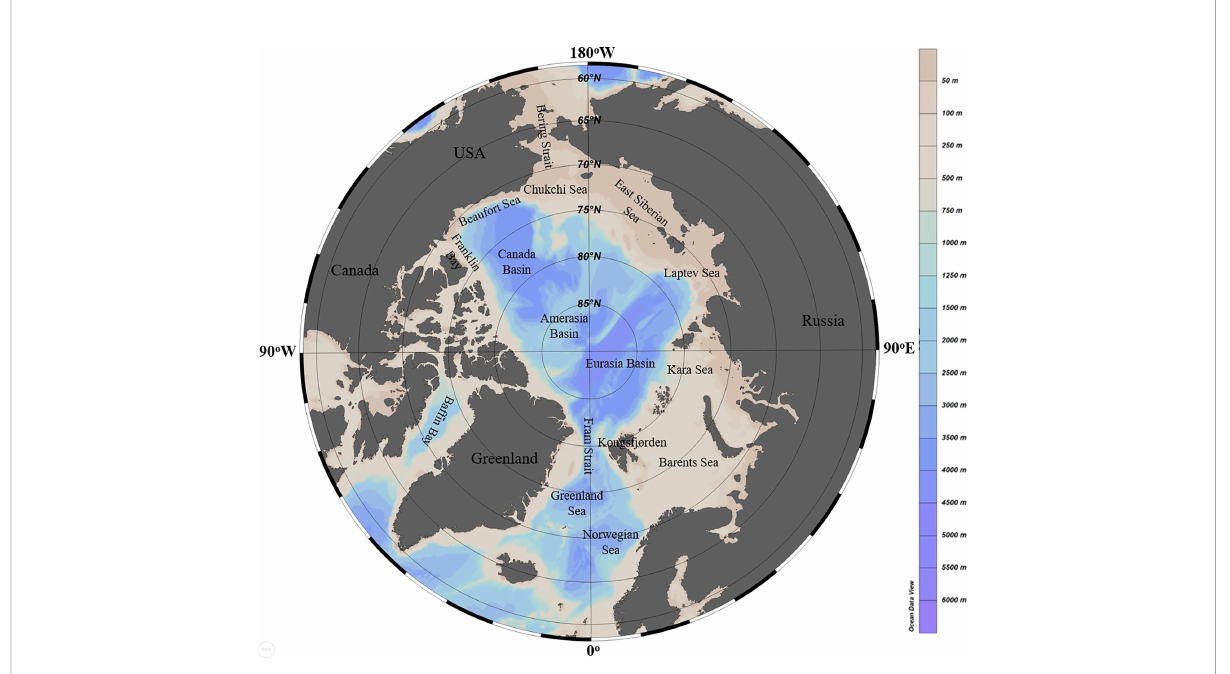
FIGURE 1 Arctic Ocean and its constituent seas. The map was created by using the Ocean Data View software (Schlitzer, Reiner, Ocean Data View, odv.awi.de,